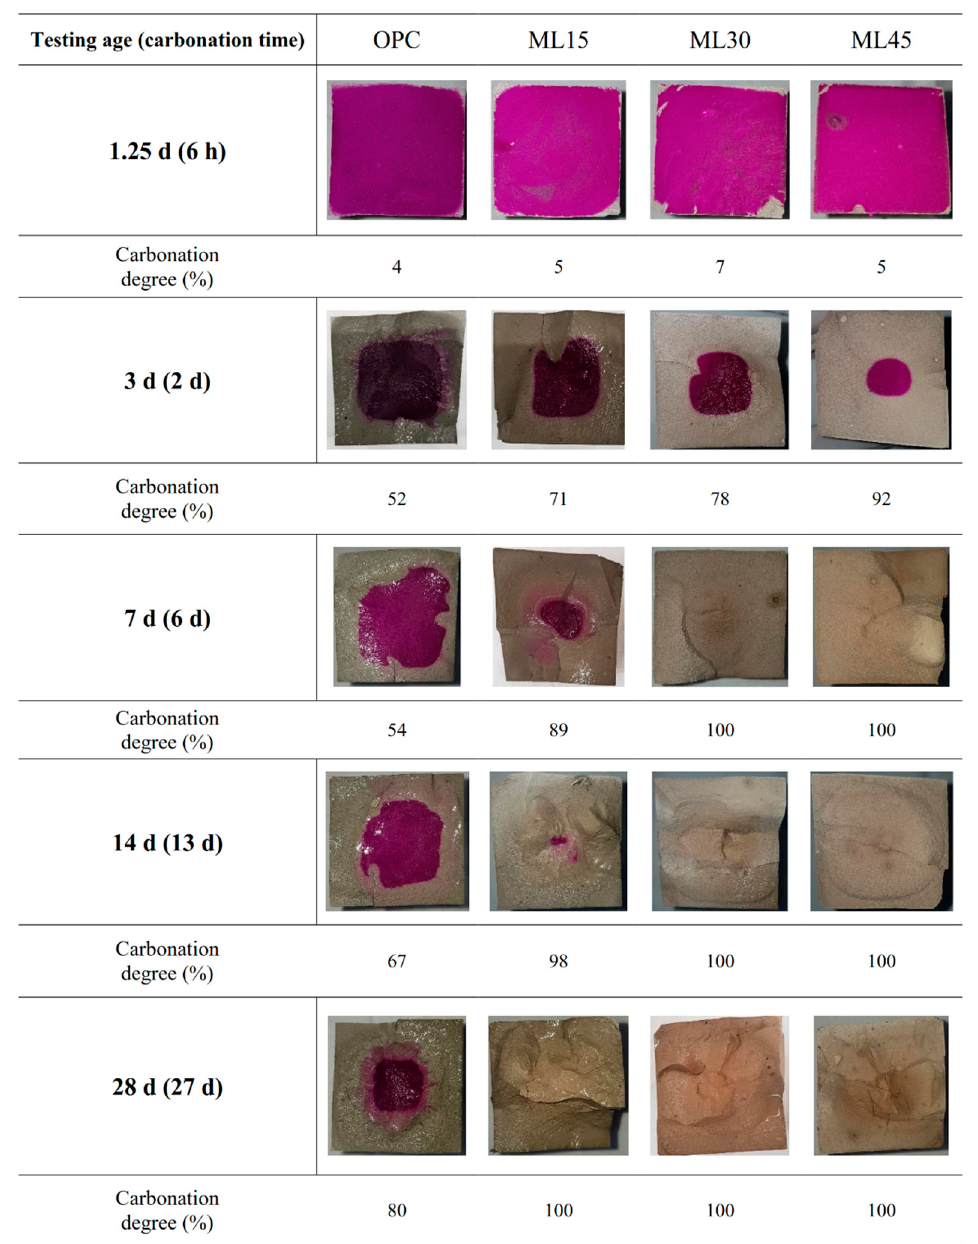
Figure 3. Carbonation degree of the samples.